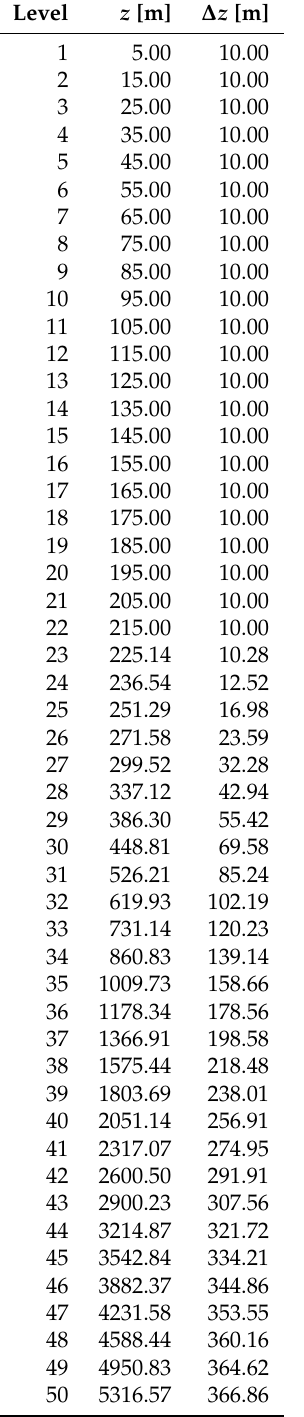
Table A2. Depth ( z ) and representing layer thickness ( ∆ z ) of NAOSIM’s vertical levels as used in